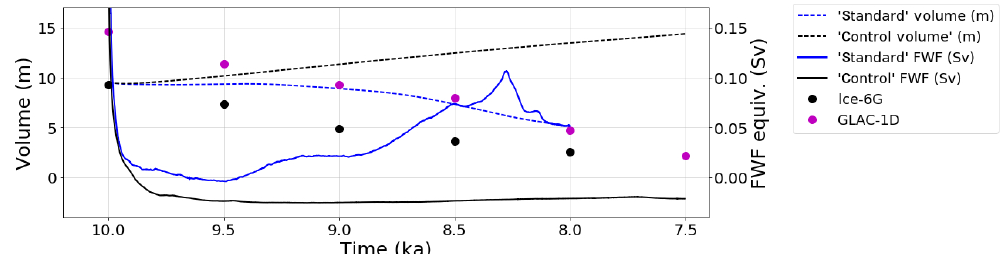
Figure 4. Evolution of ice sheet volume in metres of sea level rise equivalent (dashed line) and freshwater flux (FWF) equivalent in sverdrups (solid lines). The volumetric SLR equivalent of the ice sheet is calculated from the volume above flotation and the FWF from the total volumetric change between model years. The volume and FWF in the standard simulation are shown in blue and for the control simulation in black. The black and magenta markers show the volume in metres of equivalent SLR in the ICE-6G_c (VM5a; Peltier et al., 2015) and the GLAC-1D (Tarasov et al., 2012) reconstructions.